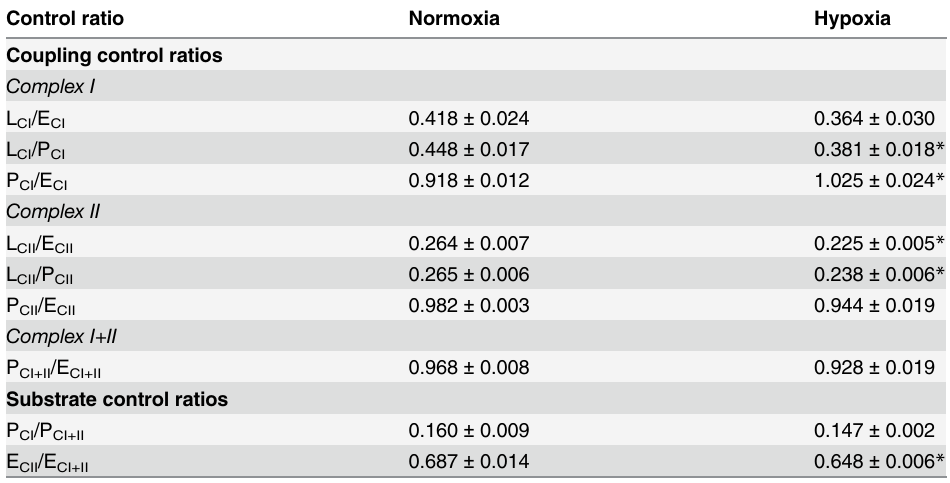
Table 5. Coupling and substrate control ratios derived from the SUIT protocols.